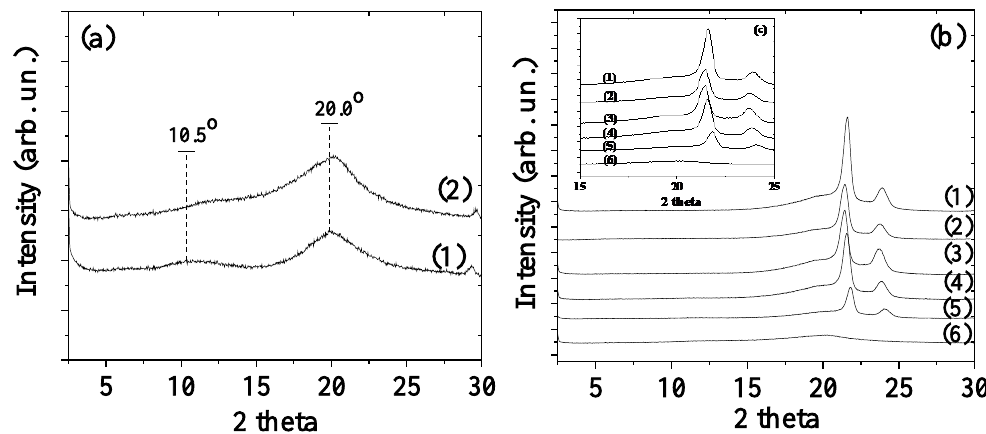
Figure 1. ( a ) XRD plots of (1) raw chitosan (CS) and (2) chitosan/basil-oil (CS_BO) powders. ( b ) and inset ( c ) XRD plots of (1) neat low-density polyethylene (LDPE), (2) LDPE/CS_BO5, (3) LDPE/CS_BO10, (4) LDPE/CS_BO20, (5) LDPE/CS_BO30, and (6) CS_BO powder.